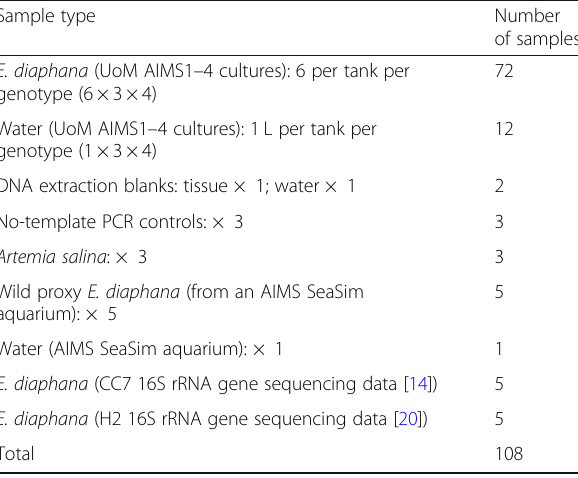
Table 1 Sampling summary for bacterial microbiota analysis Sample